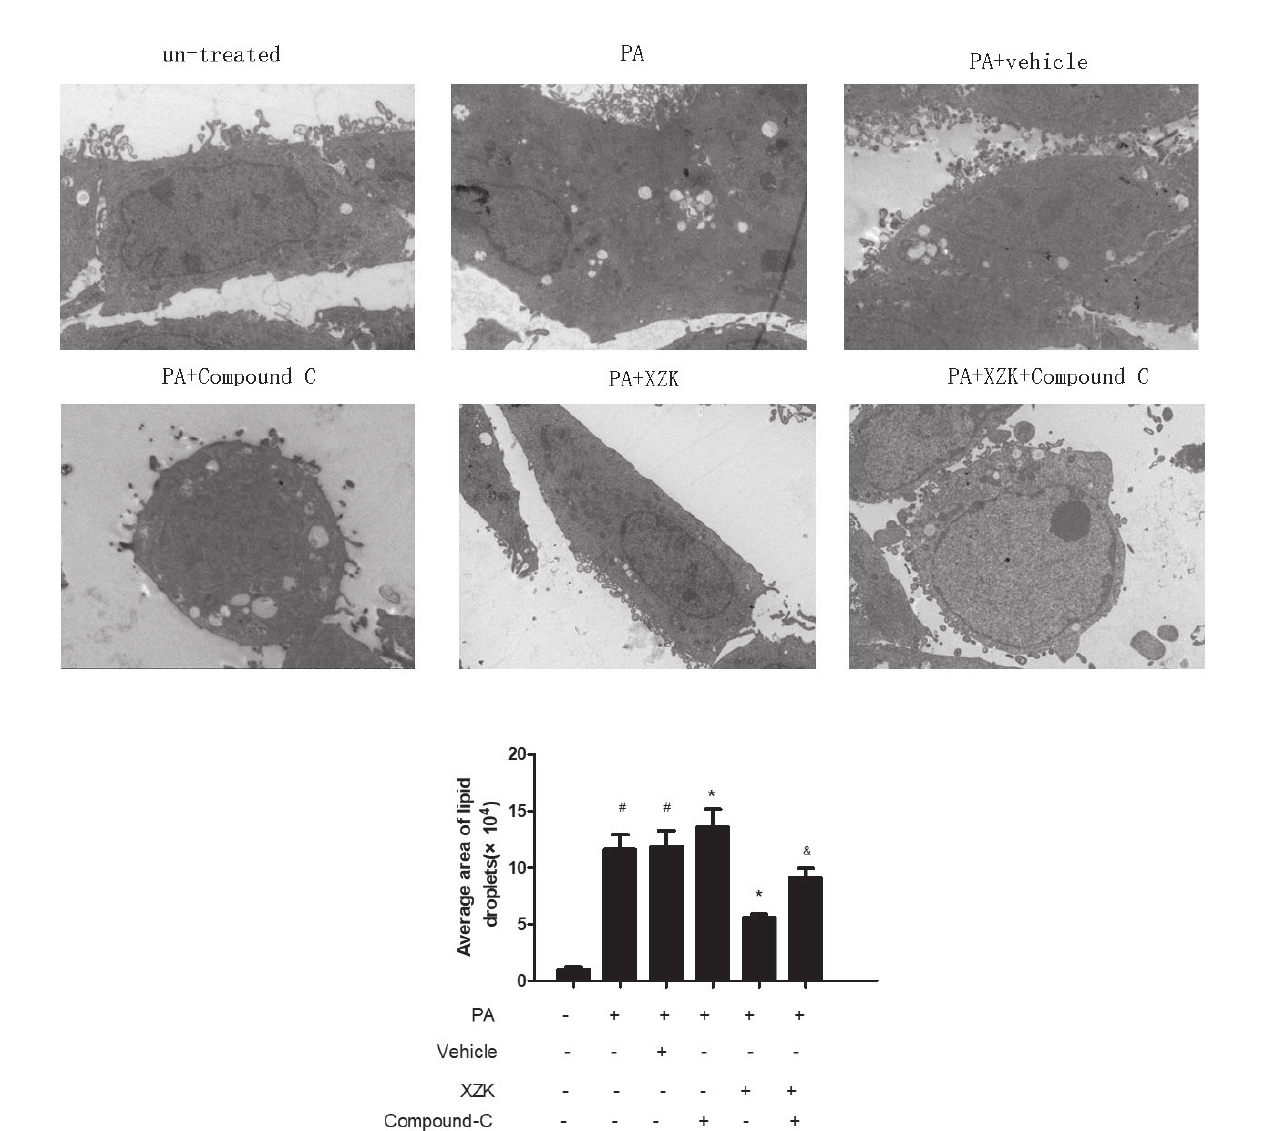
FIGURE 4 - Lipid droplets of HepG2 cells after signaling pathway inhibitor intervention. Representative images of lipid droplets were observed under transmission electron microscope. Area of lipid droplets were quantified by NIH Image J software. Results were expressed as mean±SEM from three independent experiments (n=3). Compared with the un-treated group, # P<0.05; Compared with the PA-treated group, * P<0.05; Compared with the PA+XZK treated group, & P<0.05. Scale bar,50μm